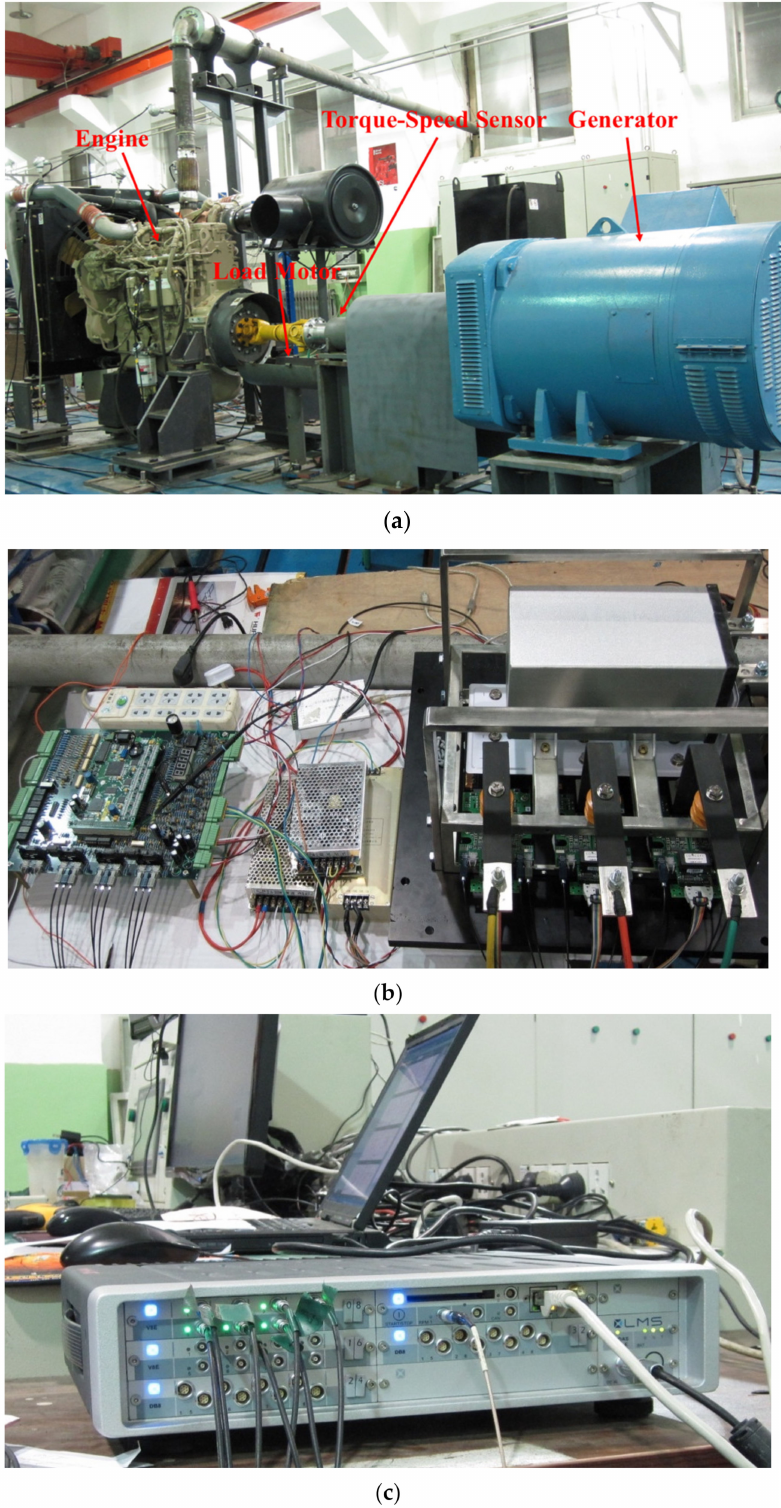
Figure 12. The powertrain experimental platform of the electric-drive mining truck: ( a ) The overall powertrain experimental platform; ( b ) The generator driving control system; ( c ) The SCADAS signal acquisition system of